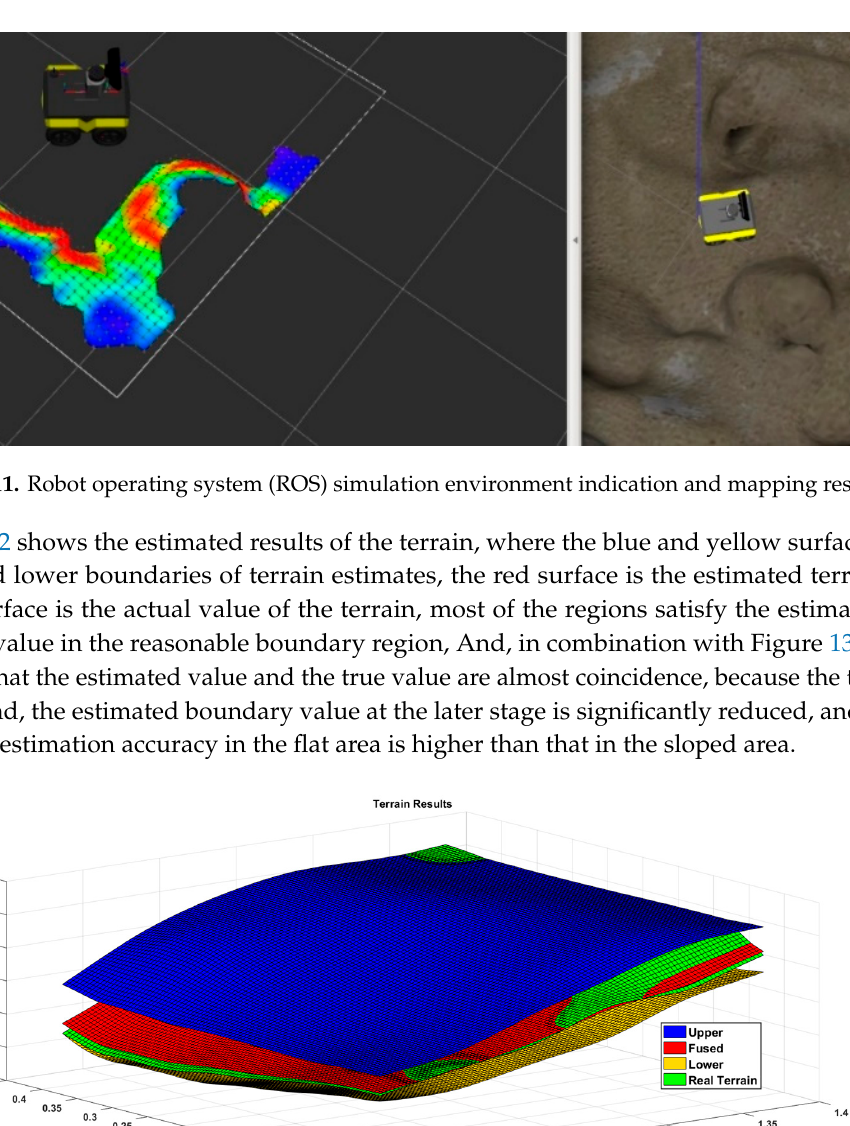
Figure 13. Details of the intersection of the terrain. In order to compare the error between the estimated value of the algorithm and the actual terrain value, as shown in Figure 14, the details of the red and blue regions are compared. From the red elliptical region, the maximum height estimation error is 0.44 cm when the x and y values are the same; from the blue elliptical area, the maximum height estimation error is 1.363 cm when the x and y values are the same. This error satisfies the accuracy requirements in actual operation compared to the diameter of the mobile platform wheel.